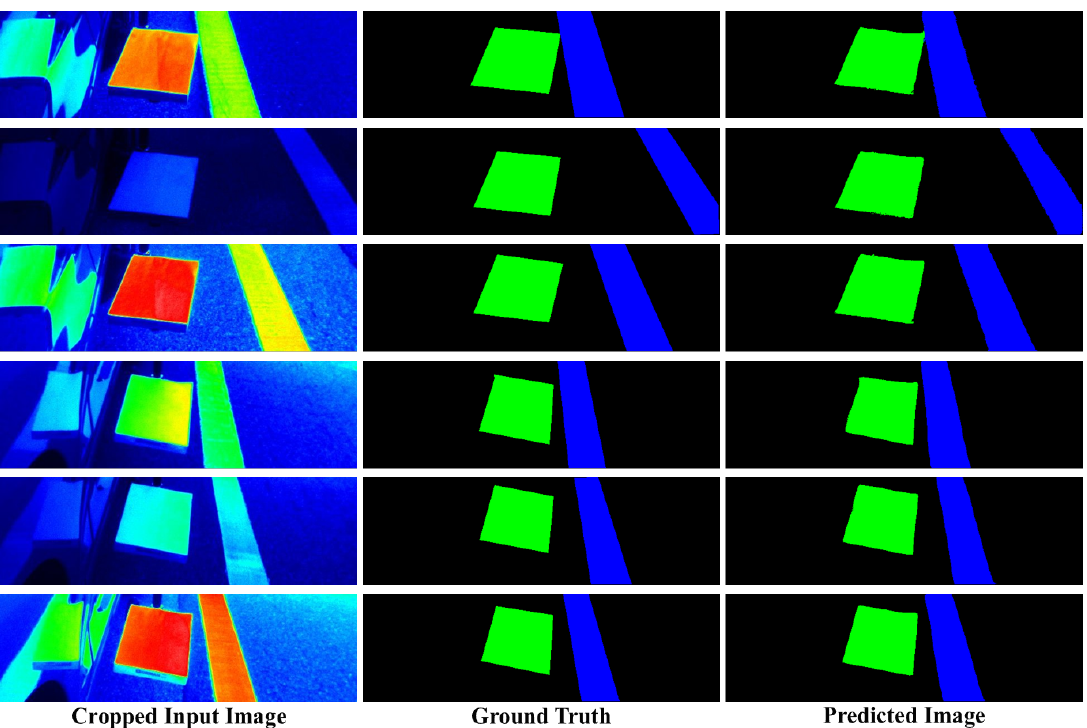
Figure 9. Examples of ground truth and segmented (predicted)